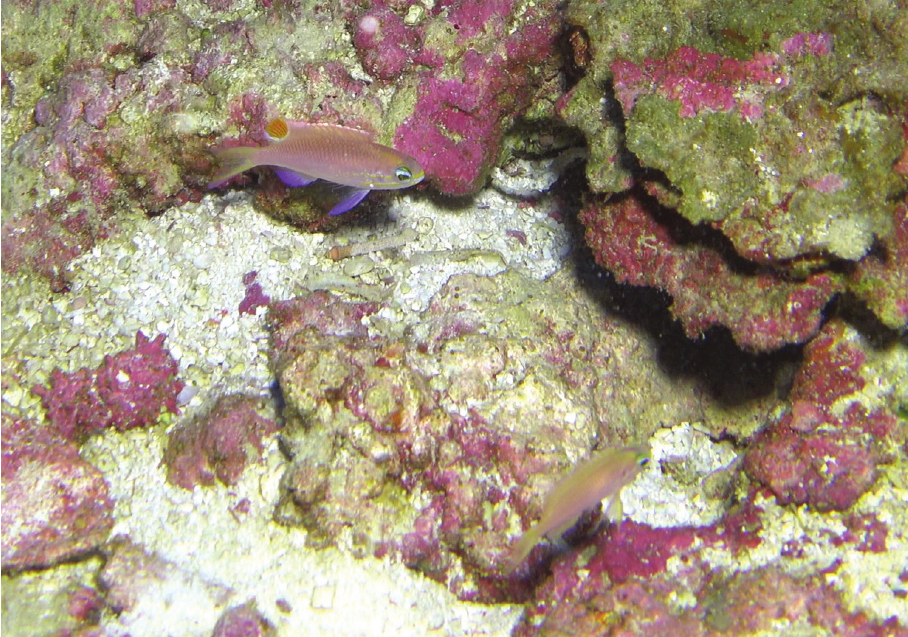
Figure 4. Holotype of Tosanoides obama (upper left) alongside presumed female (lower right, not col- lected) immediately prior to collection of the holotype, at a depth of 90 m off Kure Atoll, Northwestern Hawaiian Islands. Both fish retreated into the same hole moments after this image was captured. Cropped frame from video by R. L.